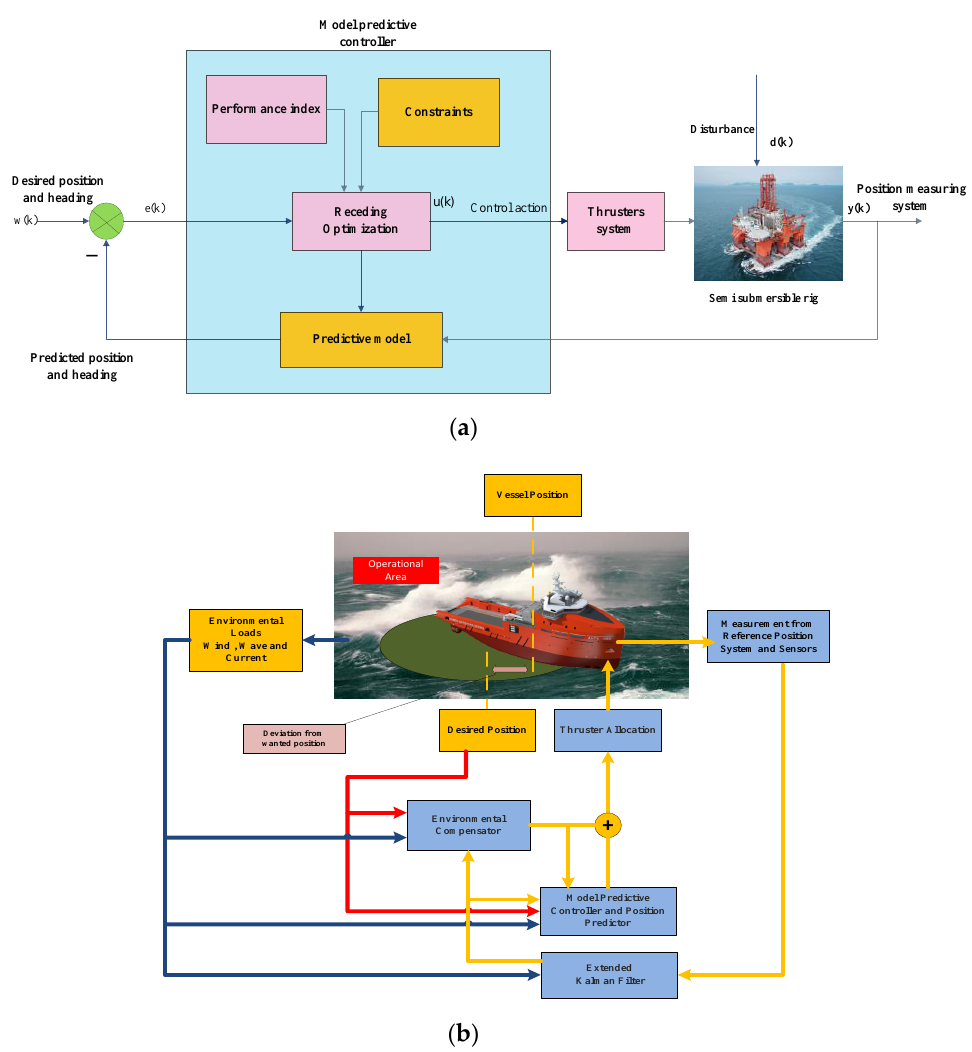
Figure 6. ( a ) Main blocks of MPC controller used in semi-submersible rigs and ( b ) the simplified block diagram of the MPC control for DP supply vessel.